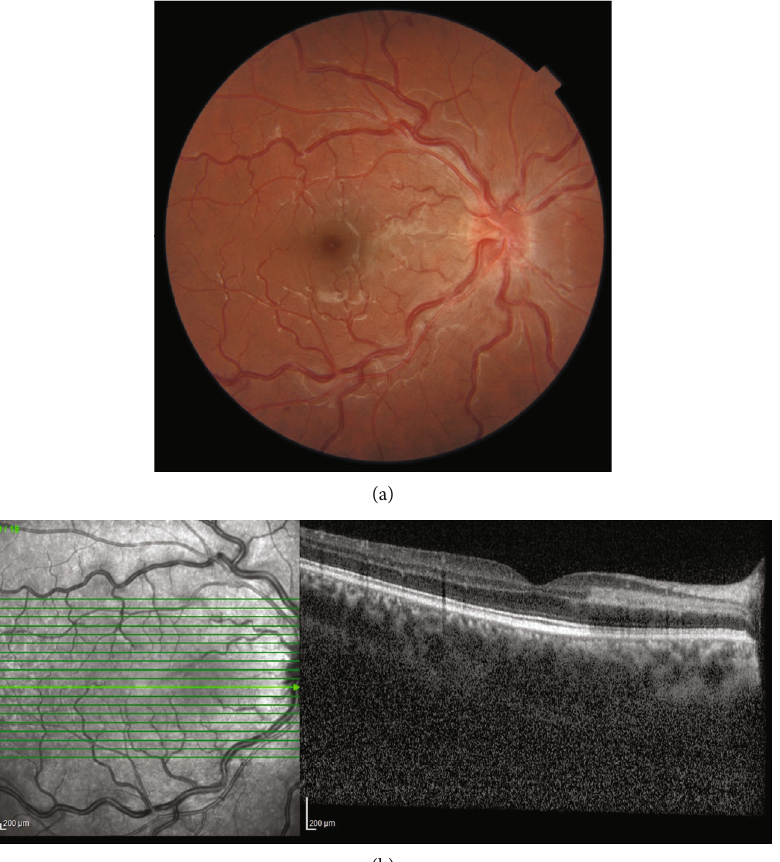
Figure 2: Fundus imaging following one month. (a) Fundus photograph of the right eye shows the vanishing of dot-like retinal hemorrhages and decrease in the opacity of papillomacular bundle lesion. (b) SD-OCT of the right eye revealed diminution in the thickness and edema of the hyperre fl ective retinal